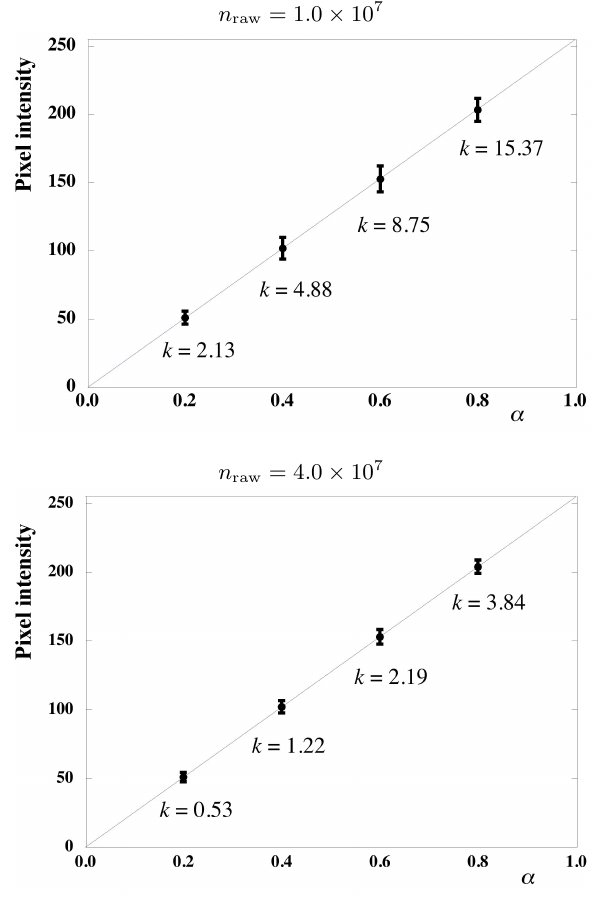
Figure 5. Pixel intensities for various values of (cid:11) when visualiz- ing a white plane with a black background. L is 1000 , and the image resolution is 512 2 . The solid lines show the theoretical